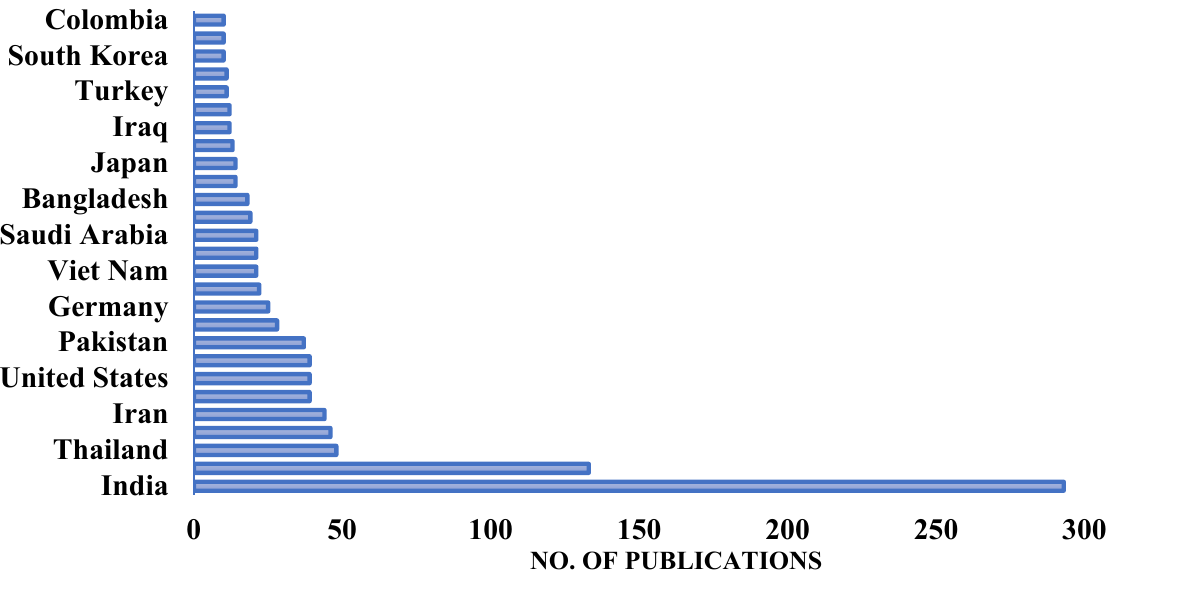
Figure 1. Number of publications on RHA.